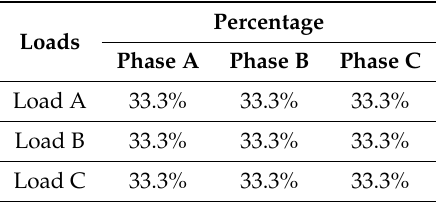
Table 1. Distribution by the phase of the balanced